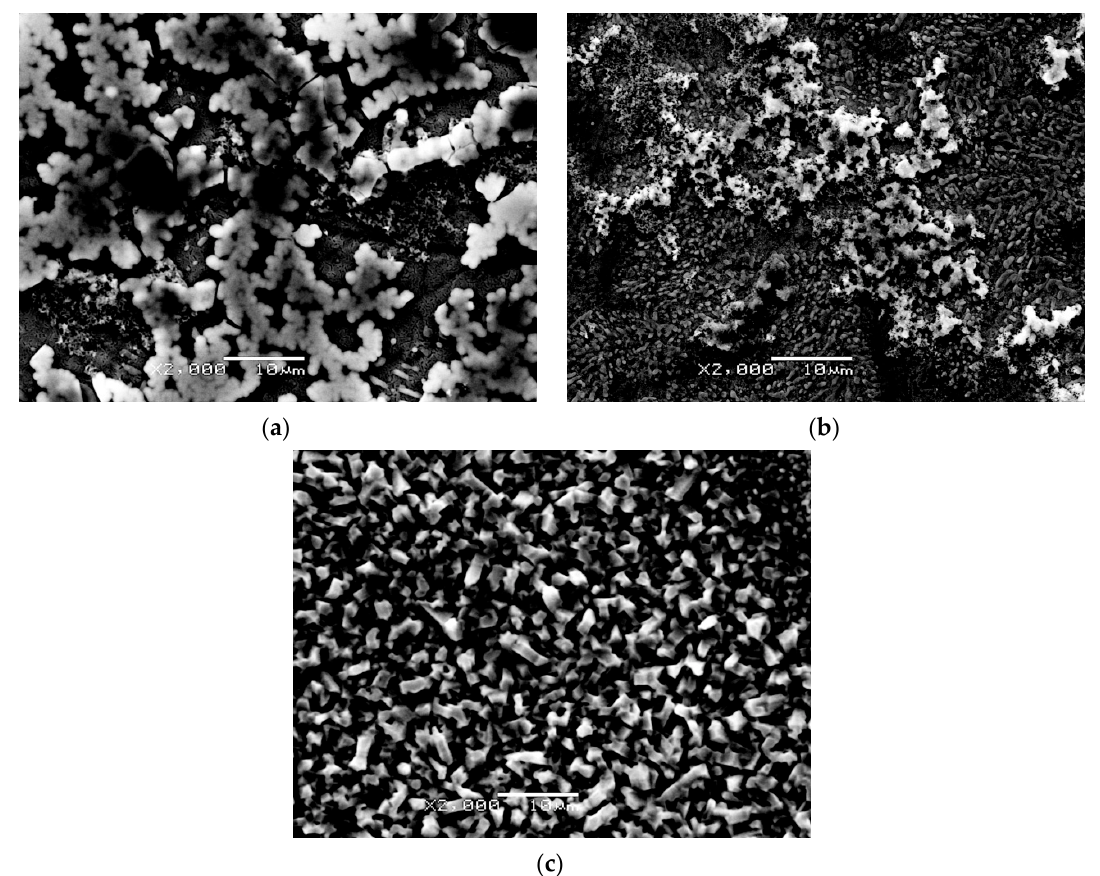
Figure 12. SEM images of the surface morphology of the alkali- and heat-treated Ti-6Al-7Nb alloy after soaking in the SBF at 36.6 °C for 24 h: ( a ) after oxidation at 600 °C; ( b ) after oxidation at 700 °C; ( c ) after oxidation at 800 °C.